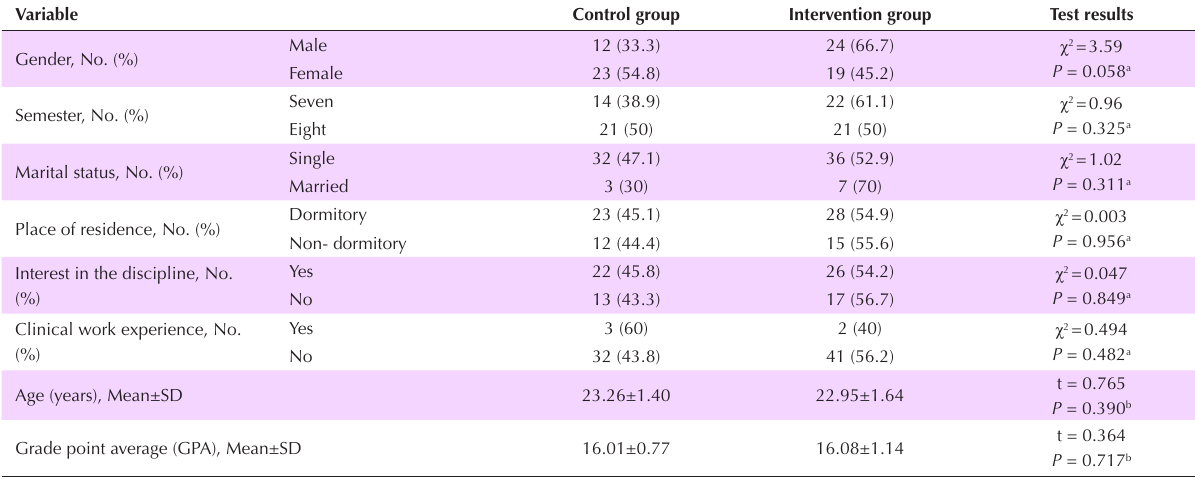
Table 3. Comparison of mean scores of patient safety-based communication skills between the intervention and control groups before and after PBL Sessions Communication skills (16-80) Before Intervention After intervention